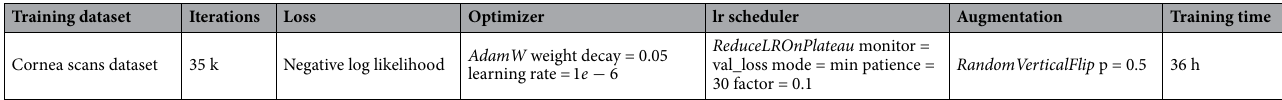
Table 2. Hyperparameters of the final CorNeXt